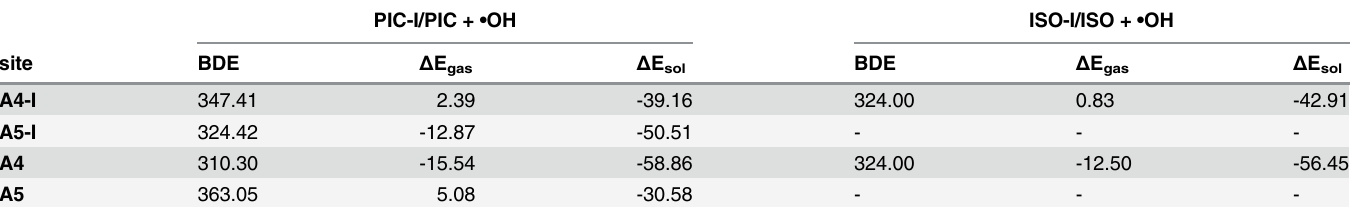
Table 8. The bond dissociation enthalpies of O-H bonds and the barrier heights of TS with zero-point energy corrections for reactions of PIC-I/PIC and ISO-I/ISO with (cid:129) OH in the gas phase and water (in kJ/mol).